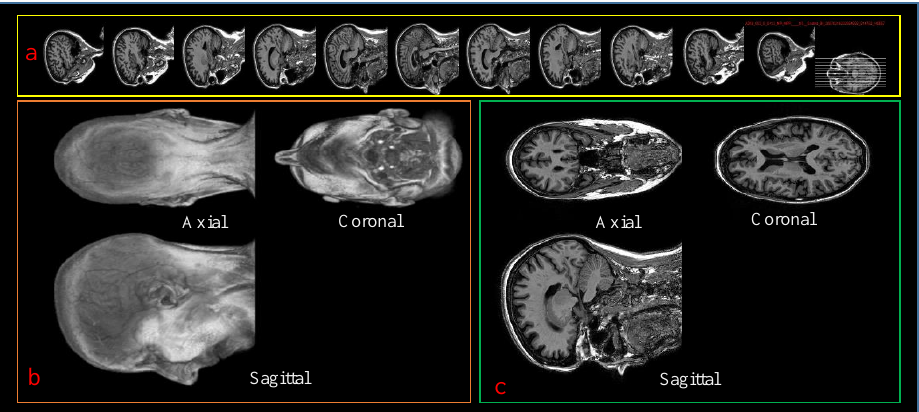
Figure 3. Overview of the capturing process. ( a ) The scans, ( b ) pre-processed 3D images of axial, sagittal, and coronal views, and ( c ) processed axial, sagittal, and coronal